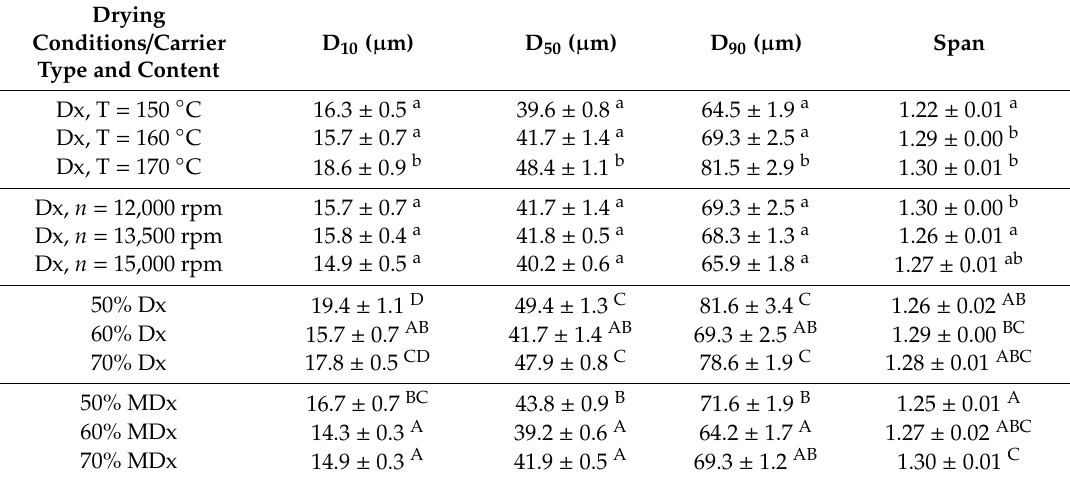
Table 1. Particle size distribution (D 10 , D 50 , D 90 , span) of spray-dried chokeberry powders. Drying Conditions /